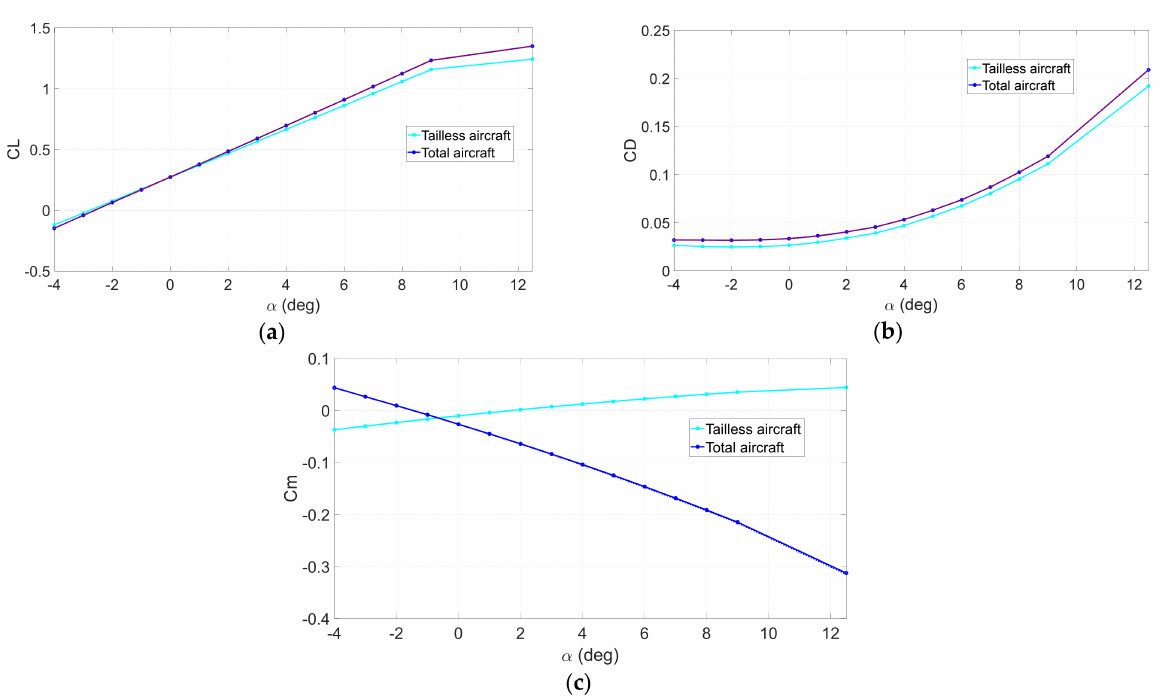
Figure 8. Longitudinal static characteristics of the proposed twin-engine aircraft model: ( a ) Lift coef- ficient results for the cruise condition; ( b ) drag coefficient results for the cruise condition; ( c ) pitching moment coefficient results for the cruise condition; (solid lines account for the optimization using mass minimization scenario and dotted-lines are for the drag optimization in trim